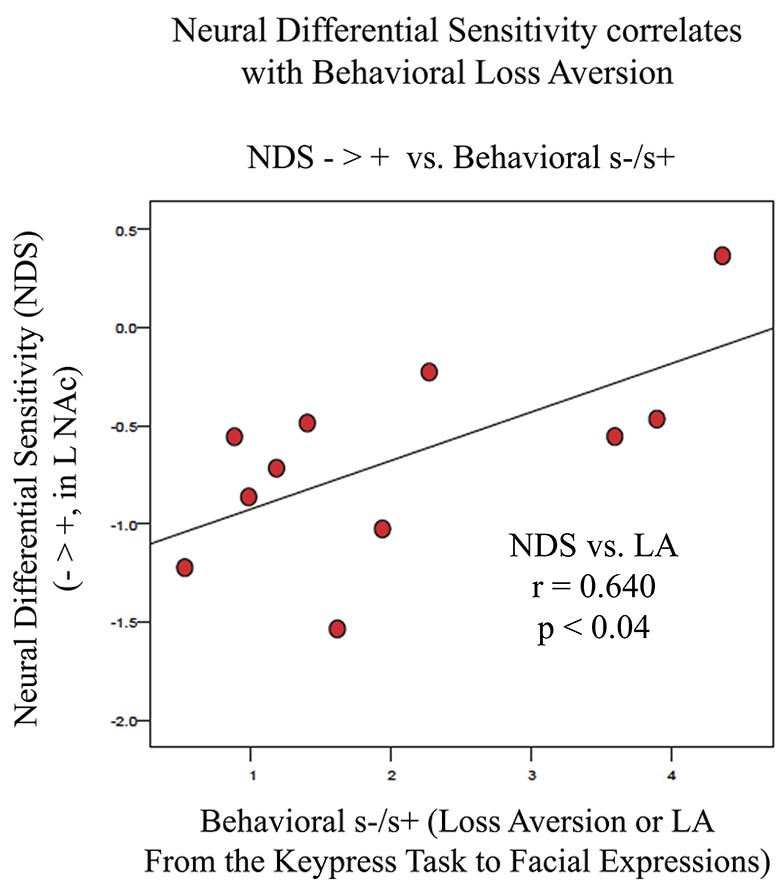
Association between LA and NDS from BOLD signal collected by fMRI. NDS represents the difference between BOLD signal in the left VS/NAc for negative stimuli (Angry, Fearful, and Sad faces) minus positive stimuli (Happy faces). LA is represented as the absolute value of s-/s+ from the relative preference graphs of each subject as shown in Figure 3. The line of best fit is shown from this association.